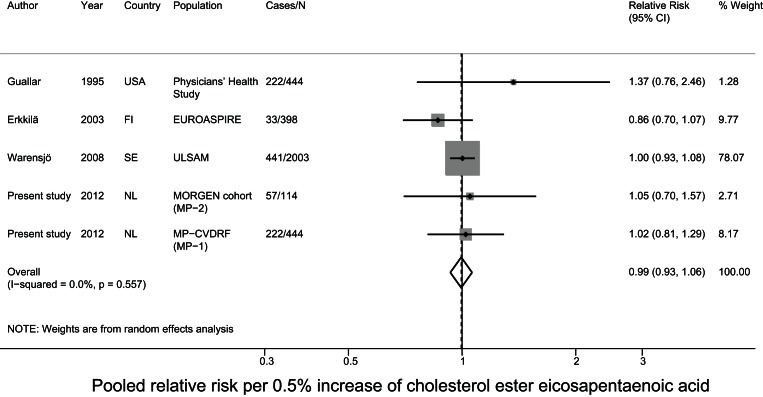
Pooled relative risk of cholesterol ester eicosapentaenoic acid and CHD risk.